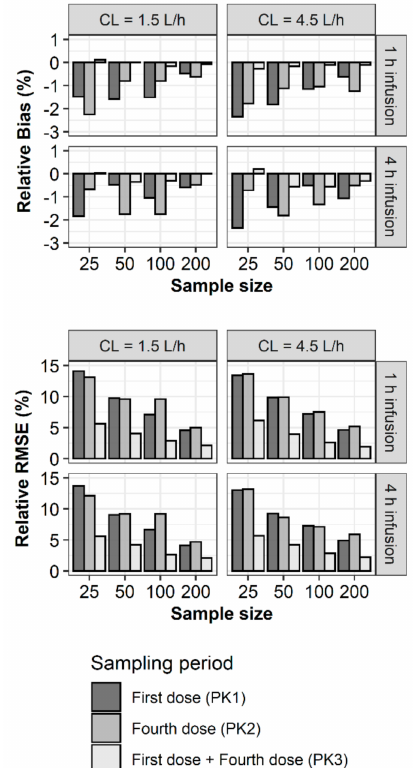
Figure 4. Relative bias ( upper ) and relative RMSE ( lower ) of residual variability in vancomycin